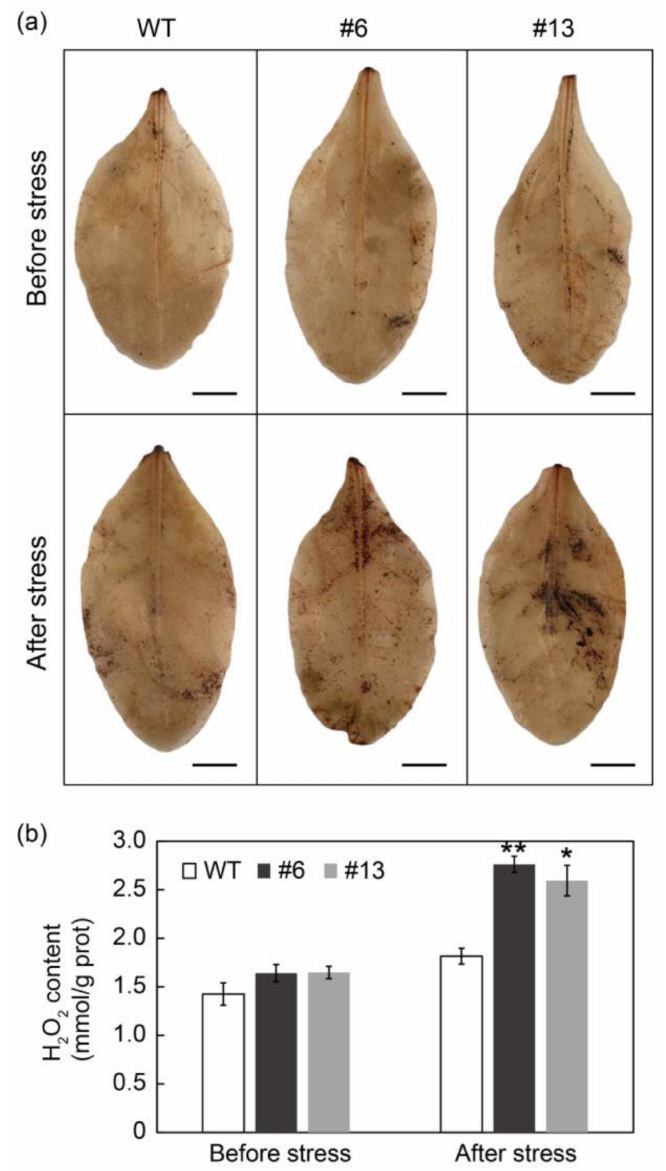
Figure 8. PtrMYB3 transgenic tobacco plants accumulate excess H 2 O 2 after salt stress. ( a ) In situ H 2 O 2 staining with 3,3 (cid:48) -diaminobenzidine (DAB) in the leaves of two transgenic lines (#6 and #13) and the WT before and after salt stress. Bar = 1 cm. ( b ) H 2 O 2 content measurement in the leaves of two transgenic lines (#6 and #13) and the WT before and after salt stress. Error bars indicate ± SE. Asterisks indicate significant differences: p < 0.05 (*), p < 0.01